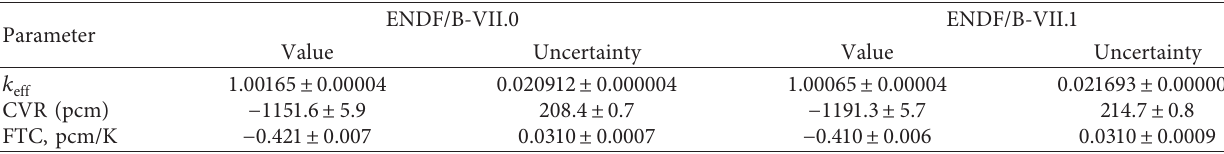
Table 4: Uncertainty results of SNF-fuelled